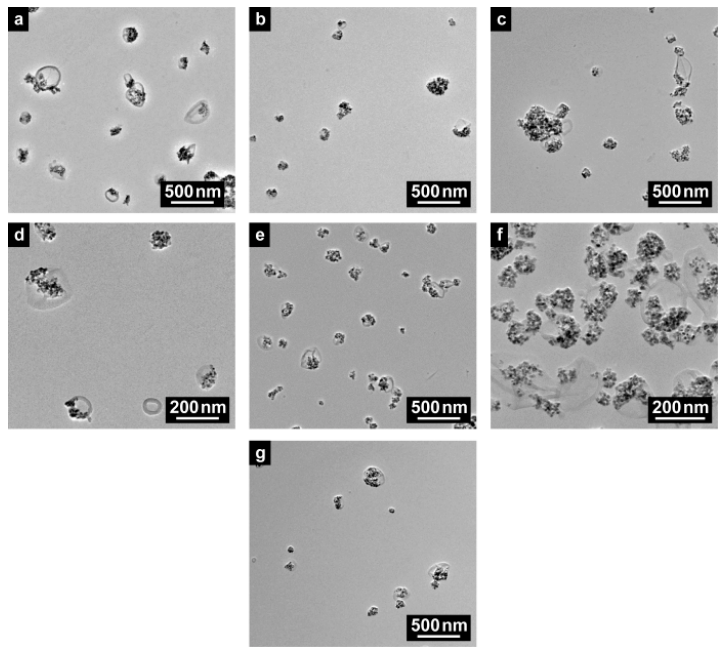
Figure 11. TEM images of MNPs-IL-C 4 @PU NCs. ( a ) 1% (PU-15a), ( b ) 2% (PU-15b), ( c ) 3% (PU-15c), ( d ) 5% (PU-15d), ( e ) 7% (PU-15e), ( f ) 9% (PU-15f), and ( g ) 11% (PU-15g) of encapsulated MNPs-IL-C 4 .